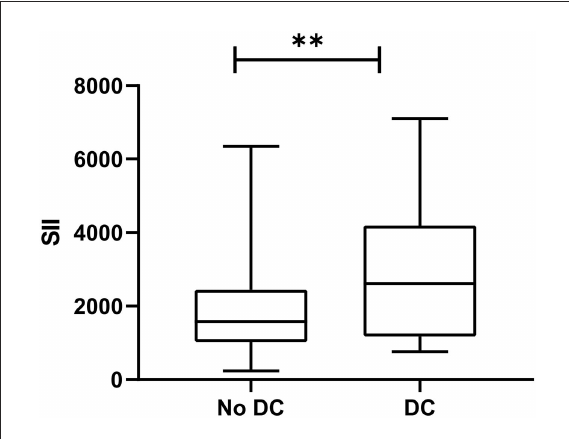
FIGURE2 Comparison of SII between experimental group and control group. * p < 0.05.